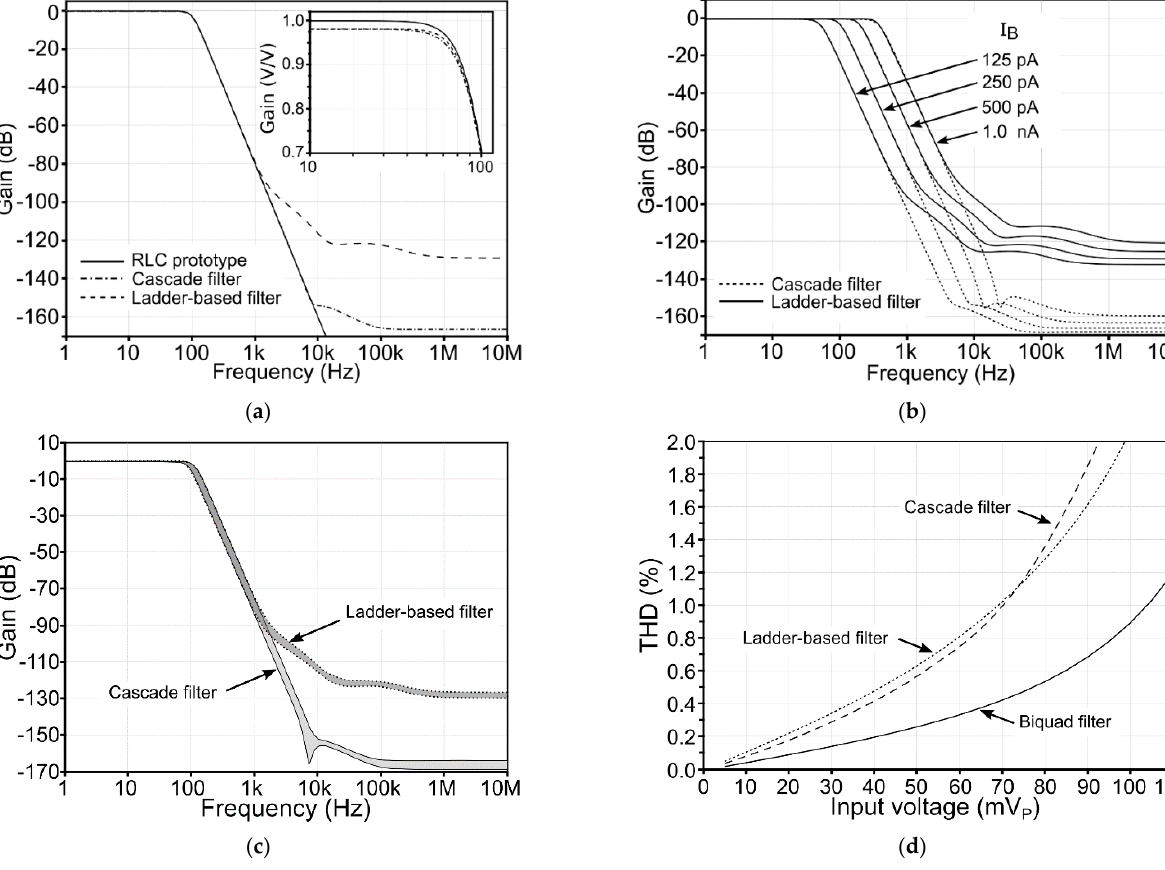
Figure 9. Simulation results of the fourth-order filters: ( a ) amplitude characteristic at the nominal bias I B = 250 pA; ( b ) bandwidth tuning; ( c ) amplitude characteristic under the process spread and transistors-&-capacitors mismatch (500 Monte Carlo runs); ( d ) output THD at the input frequency of 20 Hz and optimal input DC level of 260 mV.